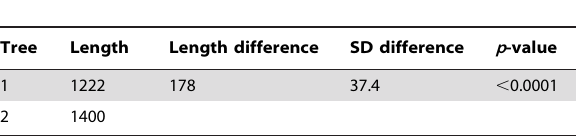
Table 1. Results of K-H test (Tree 1 = Maximum parsimony tree; Tree 2 = Raw material model